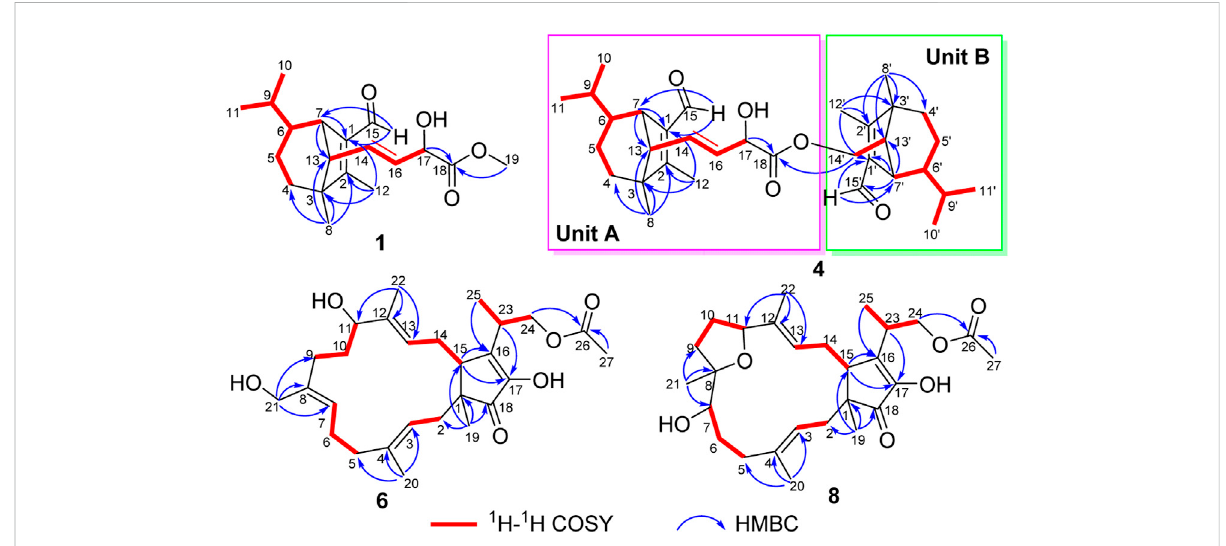
FIGURE 2 Key 1 H − 1 H COSY and HMBC correlations for 1 , 4 , 6, and 8 .